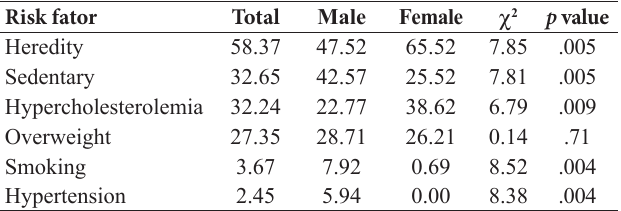
Table 3. Prevalence of coronary risk factors by